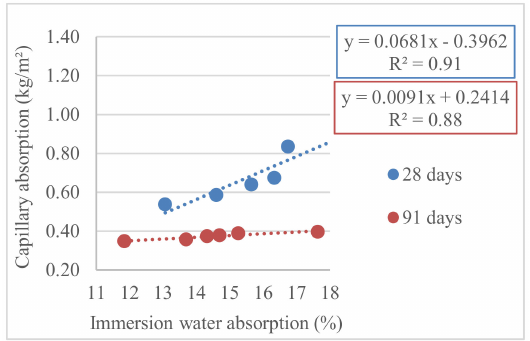
Figure 6 establishes a relationship between capillary and immersion water absorption 28 and 91 days. The high correlation coefficients (R 2 = 0.91; R 2 = 0.88) show that the capillary water absorption varies linearly with the immersion water absorption. This situation is in agreement with that found by Ferreira [59].